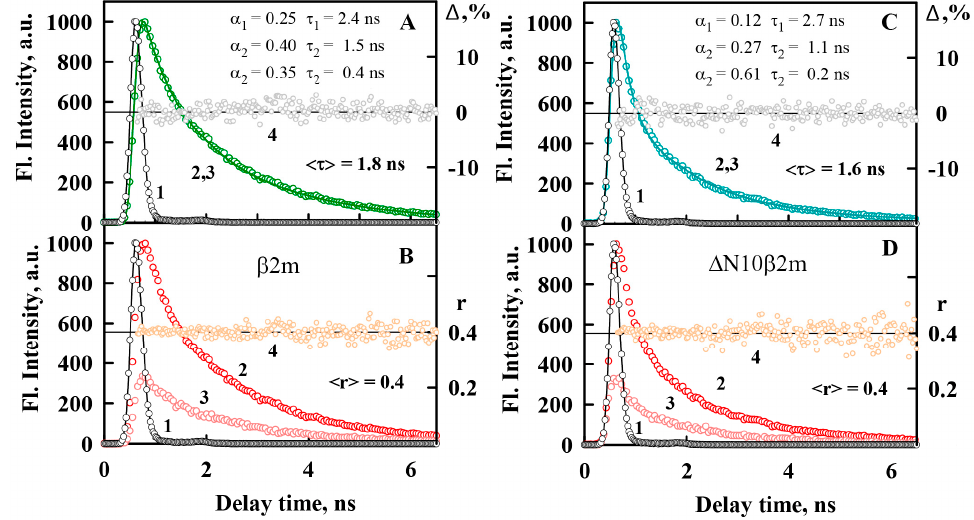
Figure 5. Time dependence of fluorescence of ThT bound to β 2m ( A , B ) and ∆ N10 β 2m ( C , D ) amyloid fibrils. ( A , C ) Fluorescence decay curves of the bound to fibrils dye. The excitation laser impulse profile ( 1 ), experimental fluorescence decay curve ( 2 ), best fit calculated fluorescence decay curve ( 3 ), and deviation between the experimental and calculated fluorescence decay curve ( 4 ) are shown. The fluorescence decay curve show best fit to a triexponential decay model. ( B , D ) Fluorescence anisotropy of the bound to fibrils ThT. The excitation laser impulse profile ( 1 ), the decay curves of the vertical ( 2 ) and horizontal ( 3 ) components of the fluorescence, and the time-dependent change in fluorescence anisotropy ( 4 ) over time are shown.